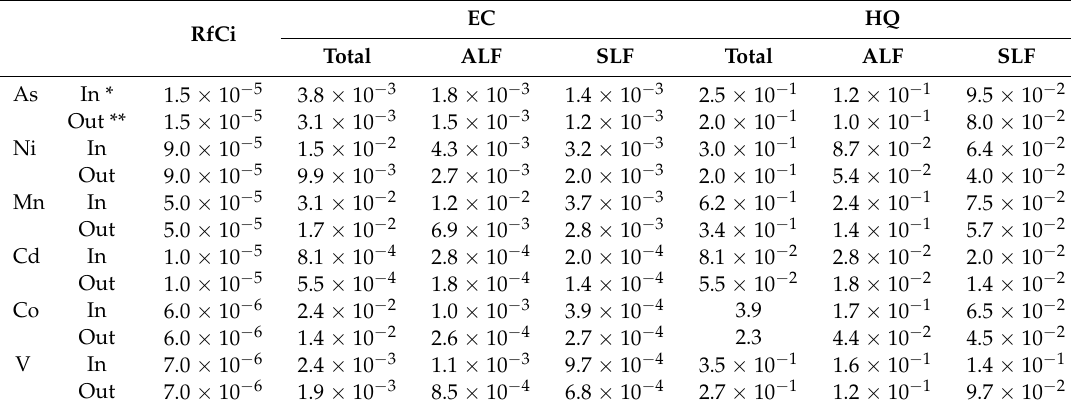
Table 4. Non-carcinogenic risks to adults from toxic elements in the indoor/outdoor <3.3 µ m fractions ( n = 10).